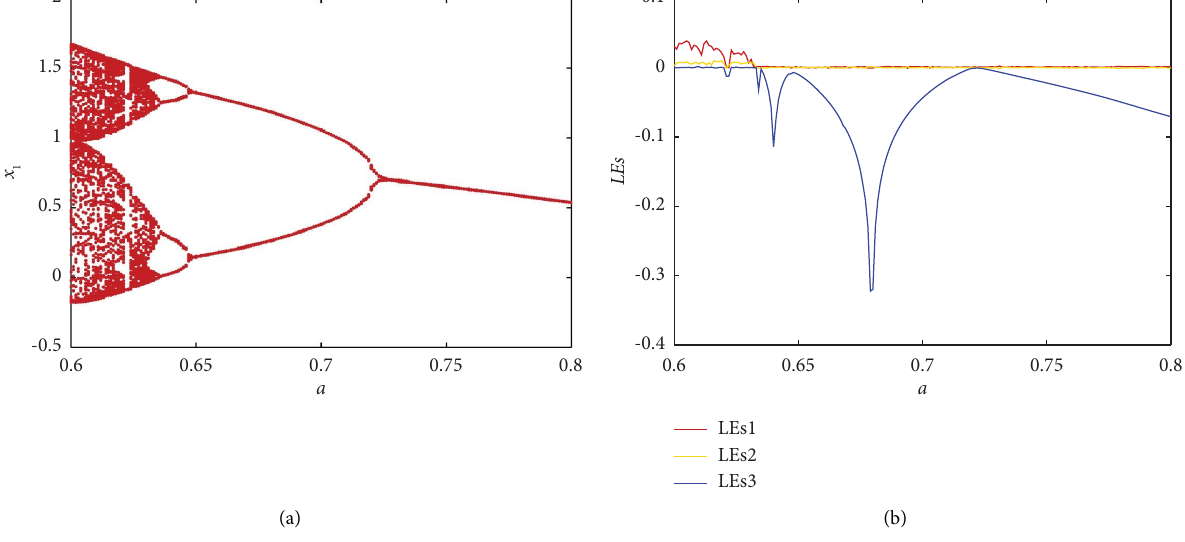
Figure 7: Parameter a change. (a) Bifurcation diagram; (b) LEs.